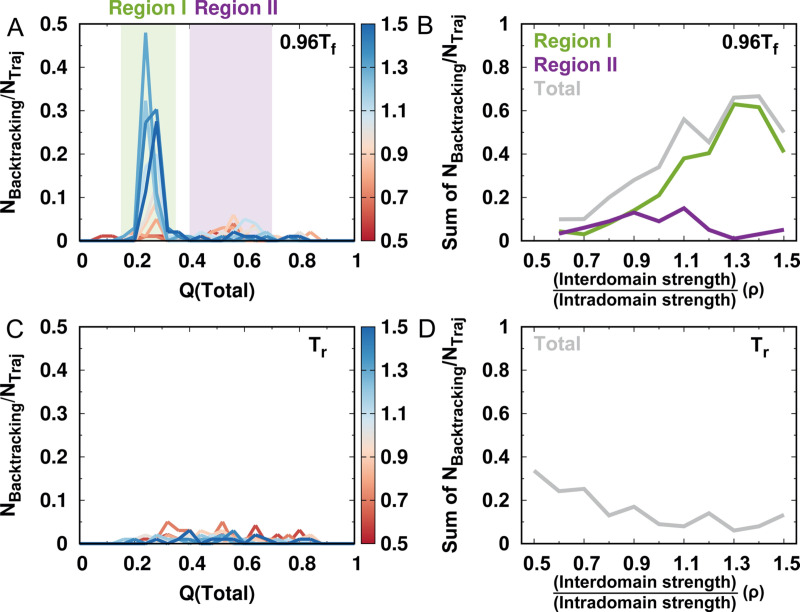
Number of backtracking observed for different values of ρ.(A) Number of backtracking observed versus Q⁢(Total) for different values of ρ. NBacktracking is the number of backtracking characterized by the averaged Q⁢(Inter) and Q⁢(Total) (Figure 2—figure supplement 3) and NTraj is the number of folding events in the simulations at a temperature 0.96⁢Tf. (B) Number of backtracking occurring in various regions for different values of ρ. (C) and (D) are the same as (A) and (B), but at room temperature Tr.